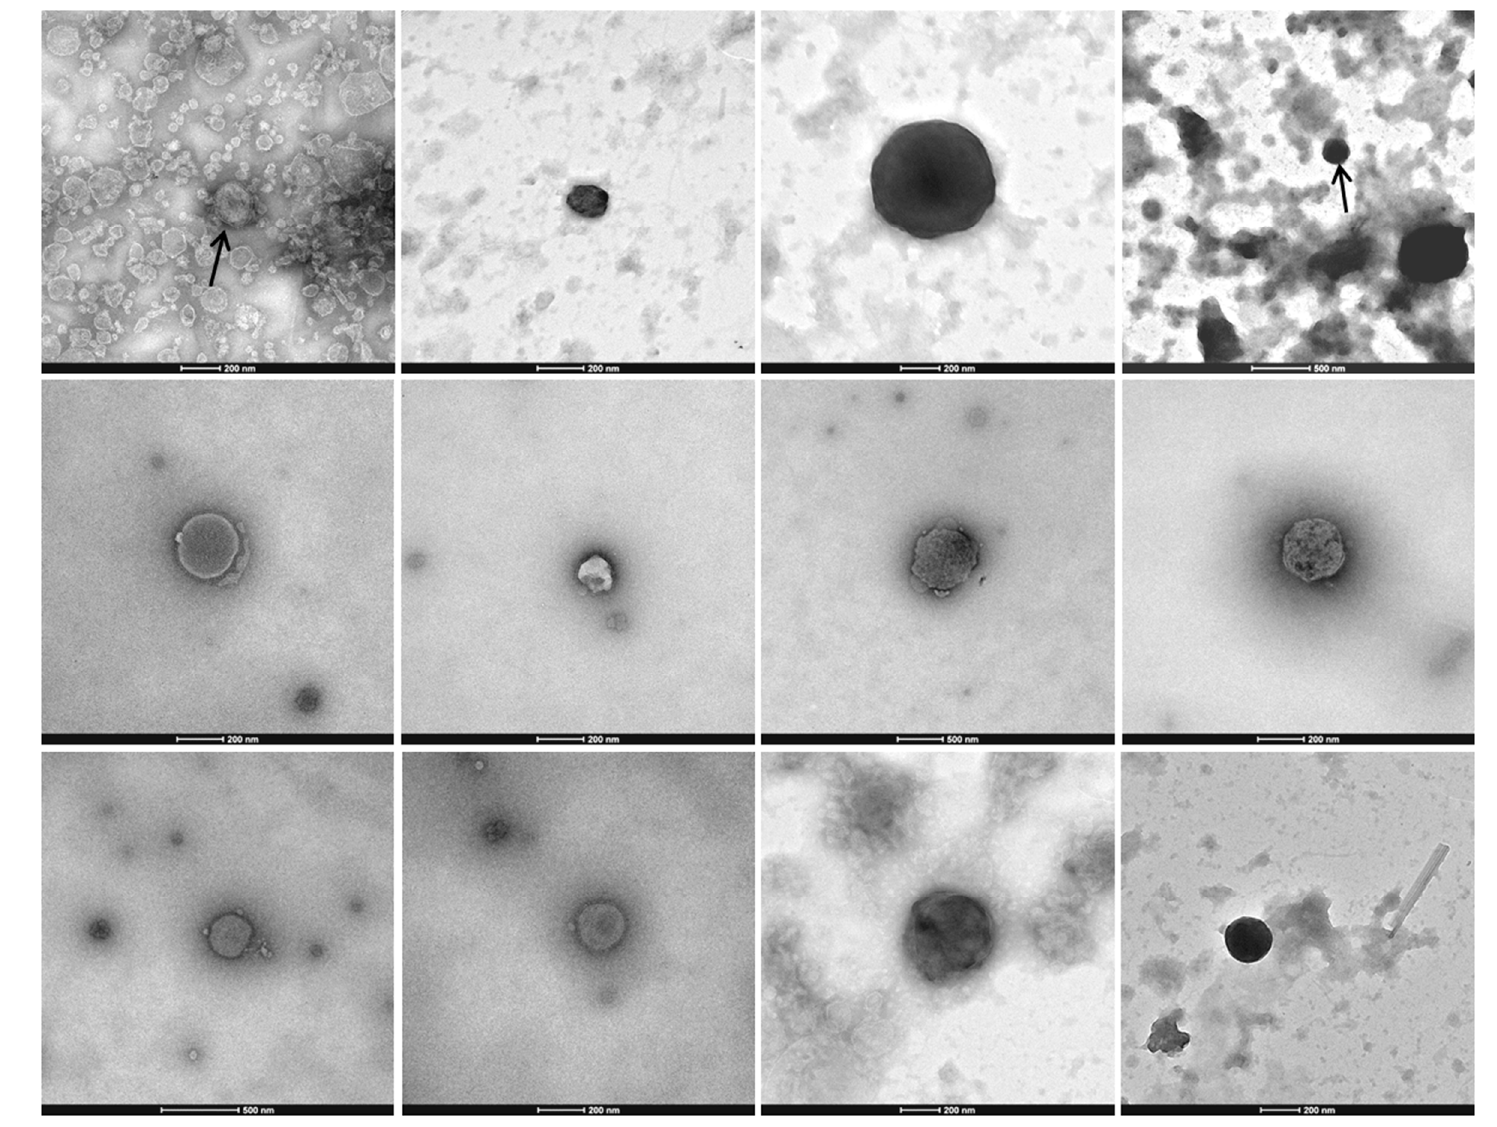
Figure 2. Repertory of transmission electron microscopy images of Culicoides sp. viral communities.